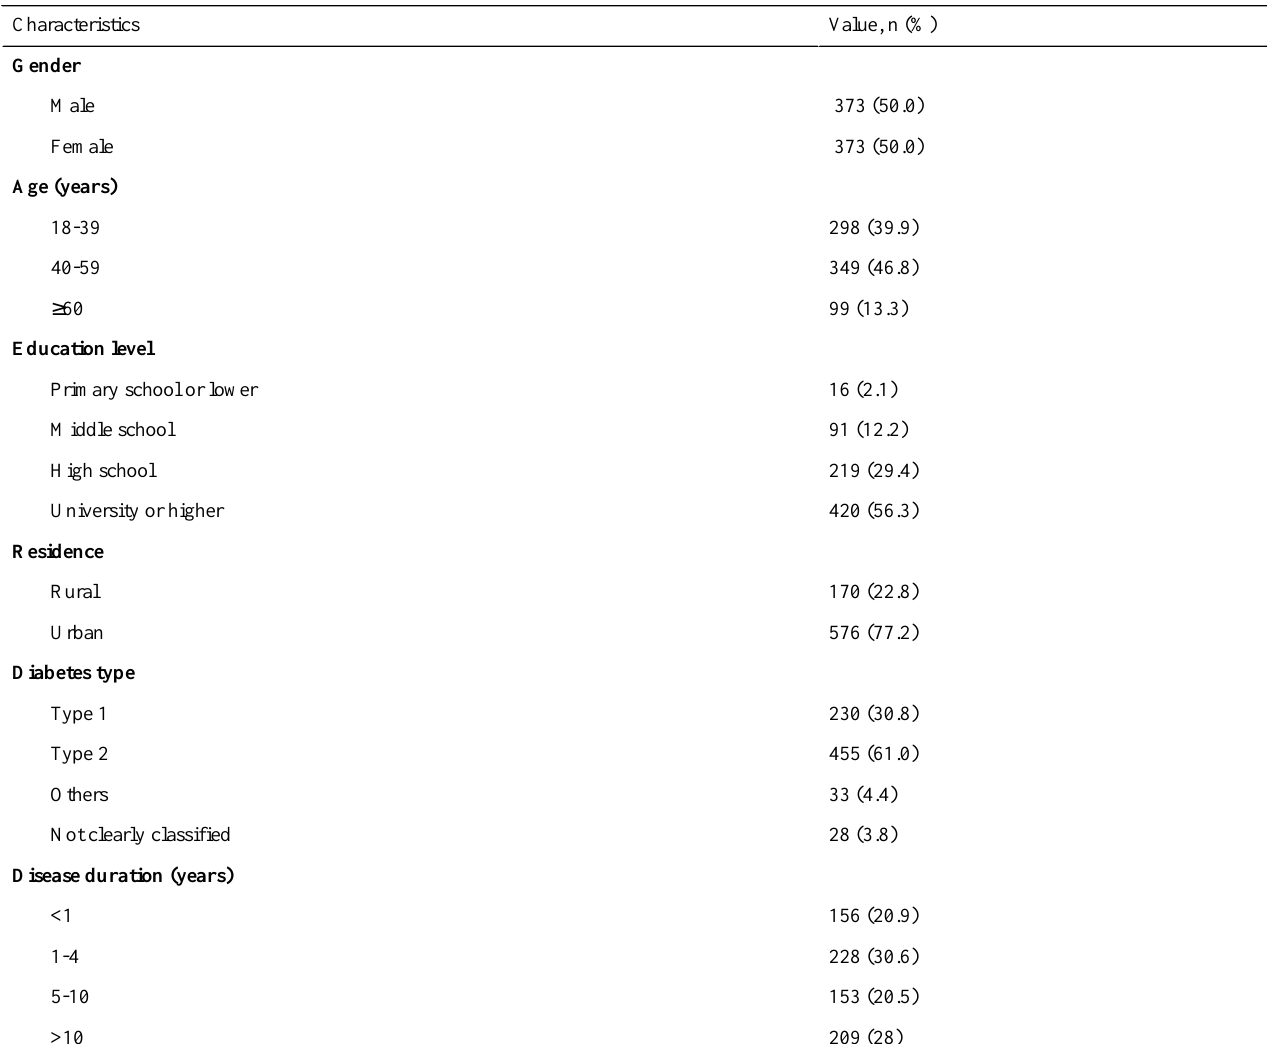
Table 3. Demographic characteristics of the qualified respondents